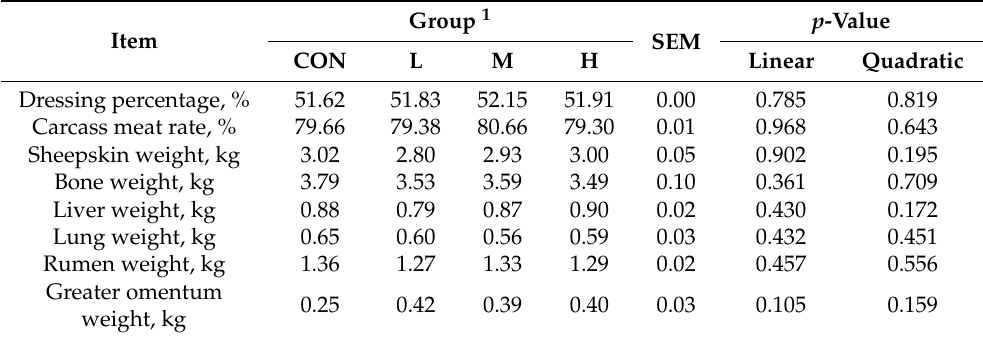
Table 5. Effects on slaughter performance of Hu lambs by substituting 0 (CON group), 20 (L